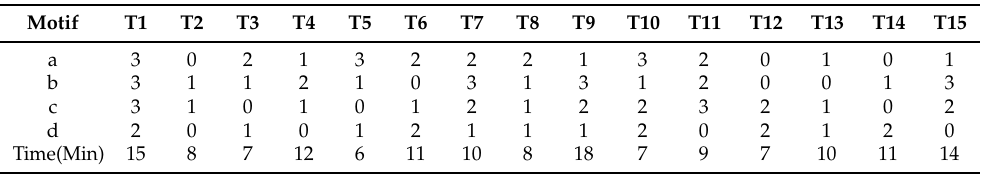
Table 2. Task information